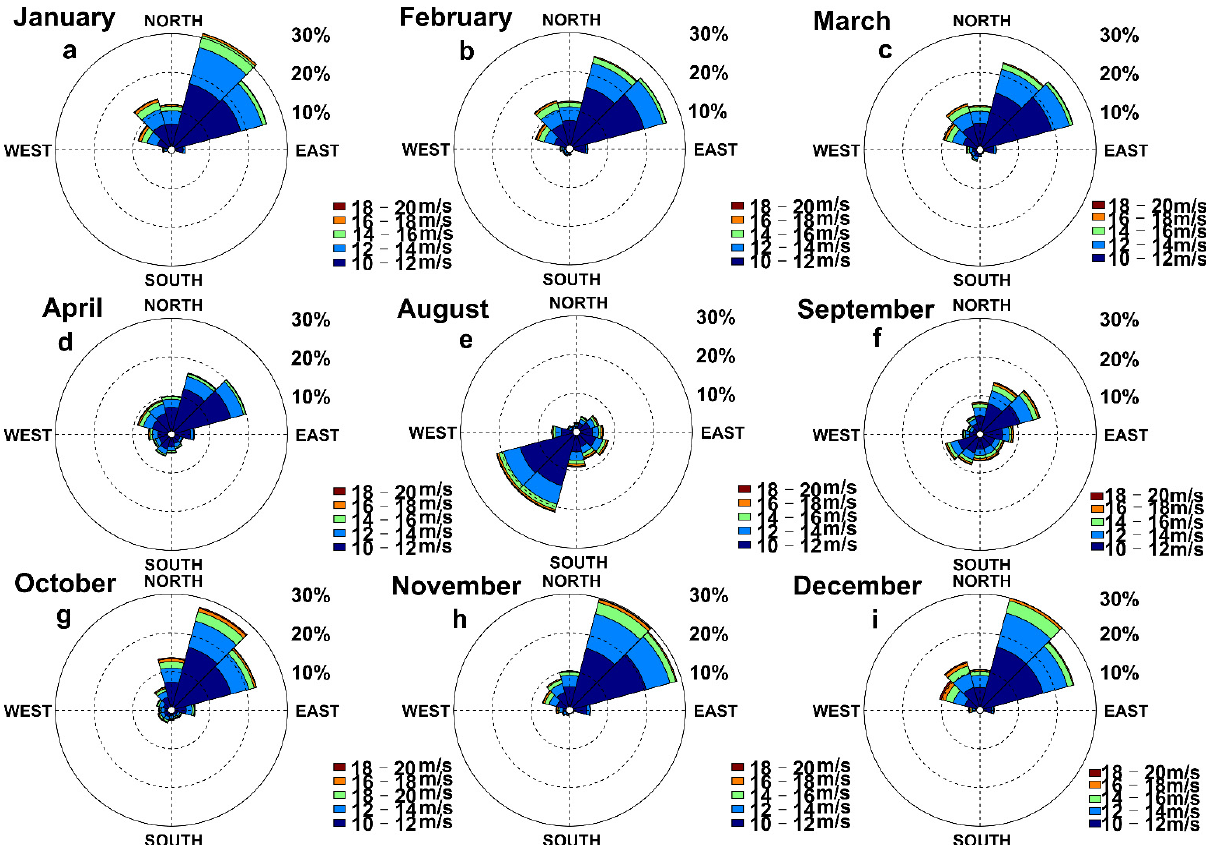
Figure 3. Wind rose map in the ECS in ( a ) January, ( b ) February, ( c ) March, ( d ) April, ( e ) August, ( f ) September, ( g ) October, ( h ) November, ( i ) December.